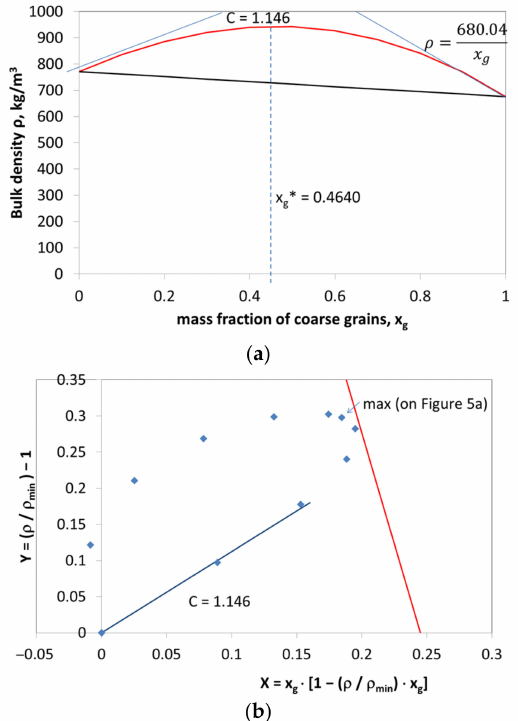
Figure 5. Data according to (39) in: ( a ) Cartesian coordinate system, ( b ) by model (34) taking into account linear additivity